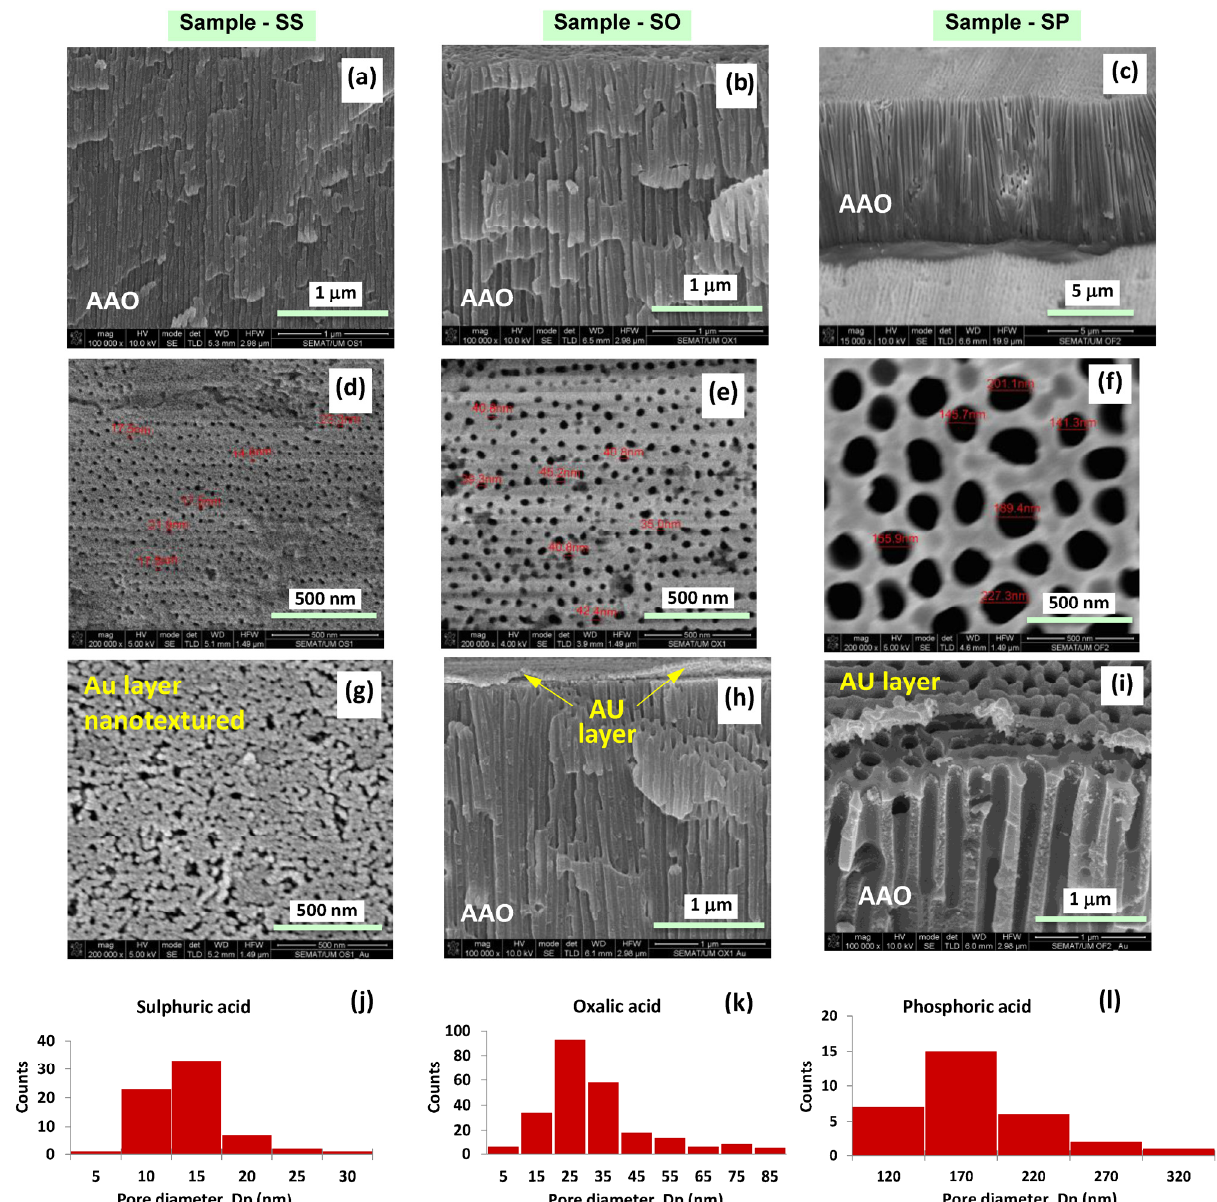
Figure 7. SEM micrographs of samples SS, SO and SP anodized in sulphuric, oxalic and phosphoric acid solutions, respectively; ( a – c ) are the cross-sectional SEM micrographs of as-prepared samples SS, SO and SP, respectively while ( d ), ( e , f ) are the corresponding surface SEM micrographs; ( g – i ) are the SEM micrographs of SS, SO and SP gold-coated samples, respectively and ( j – l ) are the size (pore diameter) distribution histogram of samples SS, SO and SP, respectively.